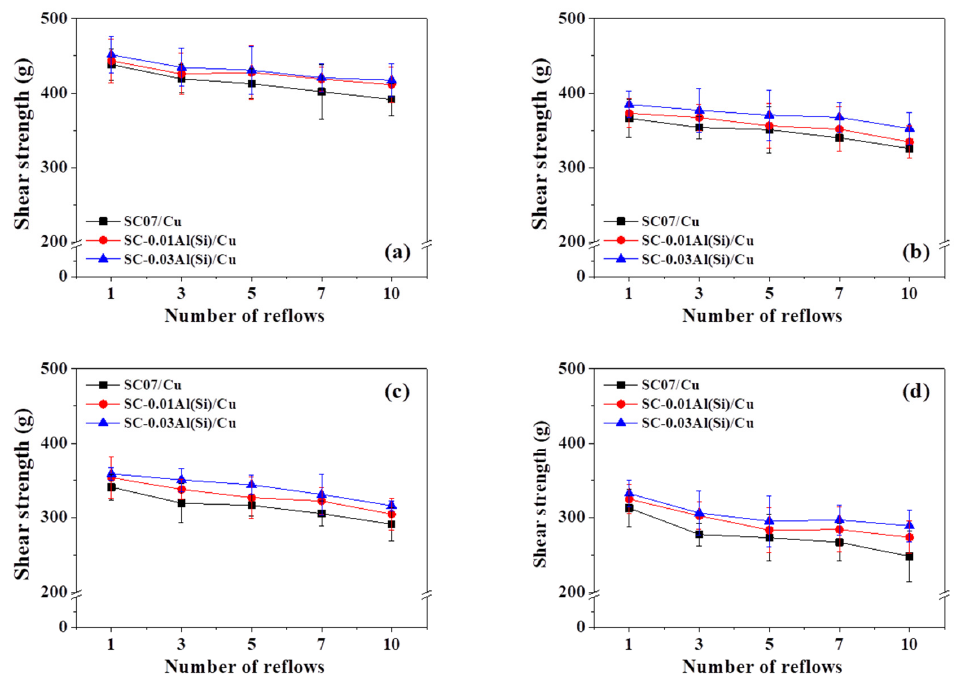
◦ C, ( b ) 125 ◦ C, ( c ) 150 ◦ C,